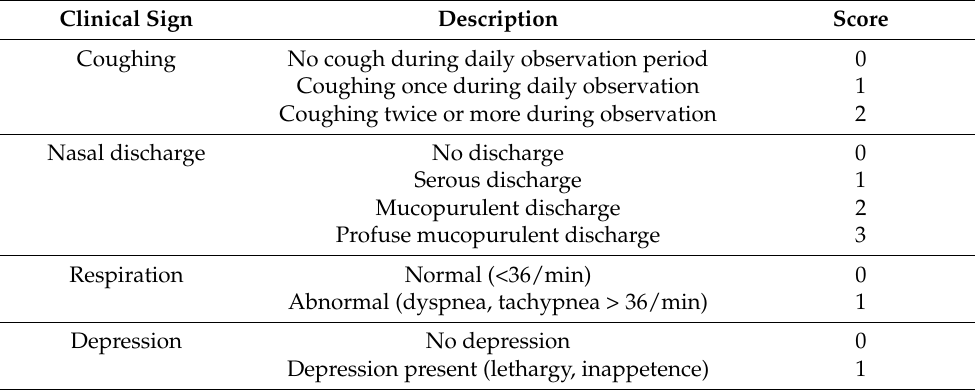
Table 5. Scoring system of clinical signs in horses infected with EIV during experimental challenge. Clinical Sign